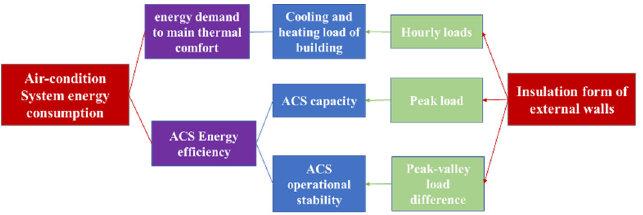
Figure 1. Conceptual framework of the present study.